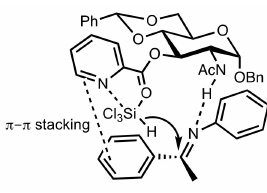
Figure 27. The proposed mechanism for the imines reduction catalysed by 365